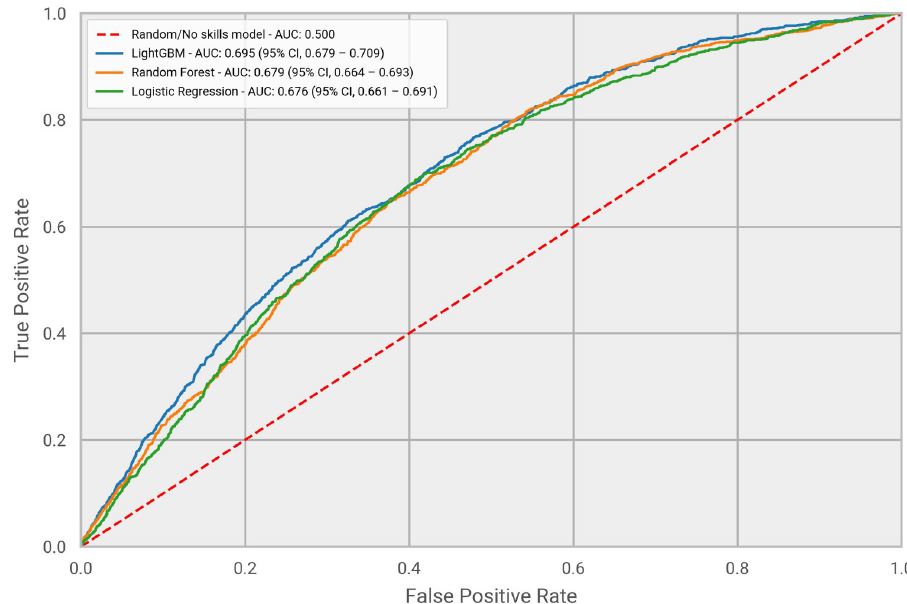
Fig 3. ROC curves. Performance evaluation of the three machine learning models, measured using a ROC curve.